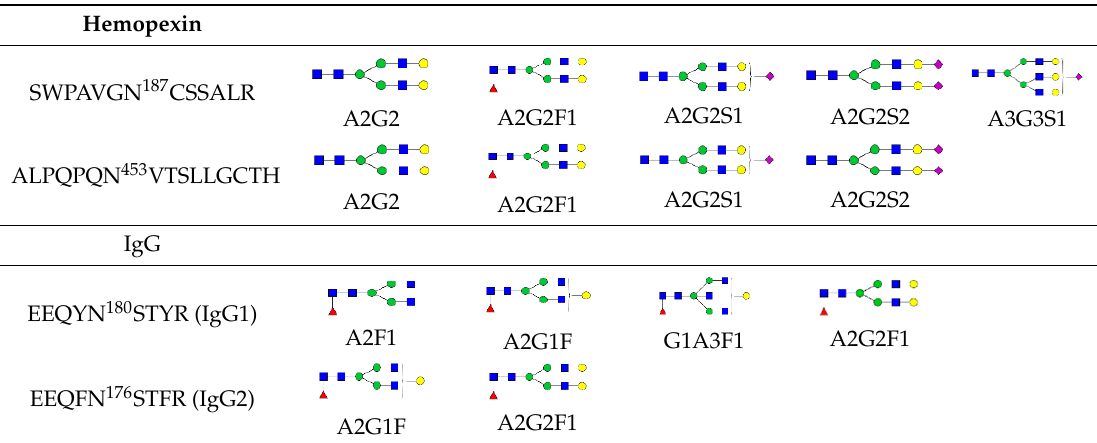
Table 1. The studied glycopeptides of hemopexin and IgG. Symbols: , N -acetylglucosamine (GlcNAc); , Mannose (Man); , Galactose (Gal); , Fucose (Fuc); , Sialic acid.